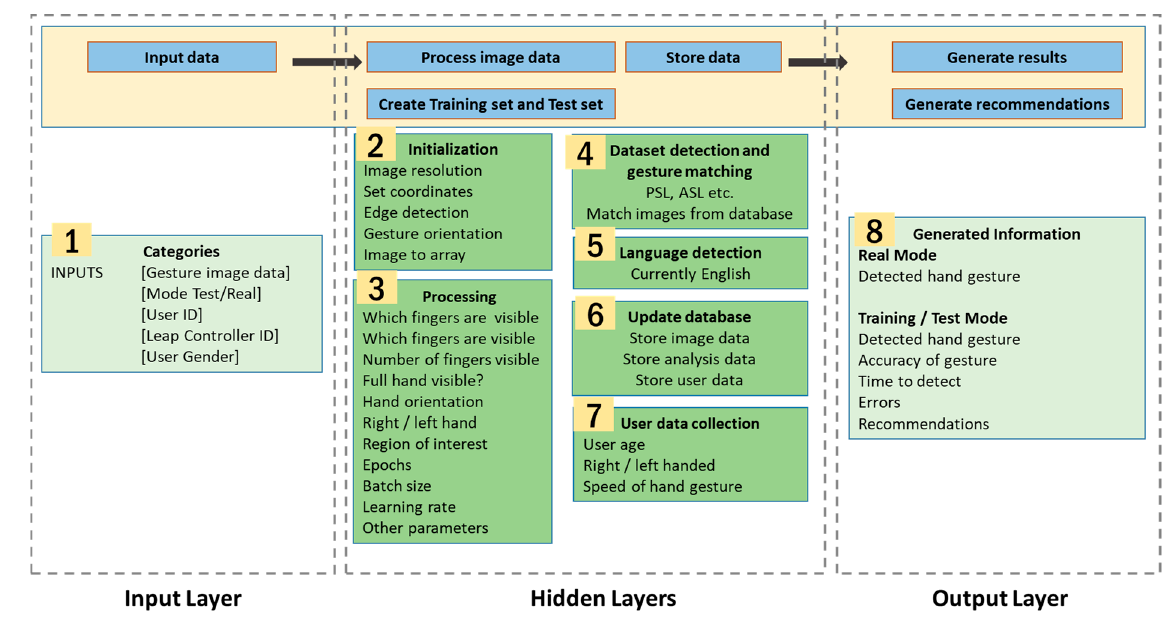
Figure 6. Machine Learning-based Actual and Training System Implementation.